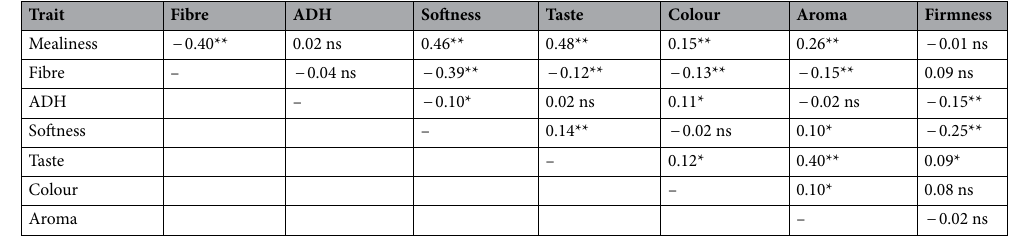
Table 2. Phenotypic correlation coefficients among end-user culinary quality traits phenotyped for 150 cassava genotypes in three environments in Nigeria. ADH, Adhesiveness; ns, Not significant. *Significant level at P < 0.05. **Significant level at P <